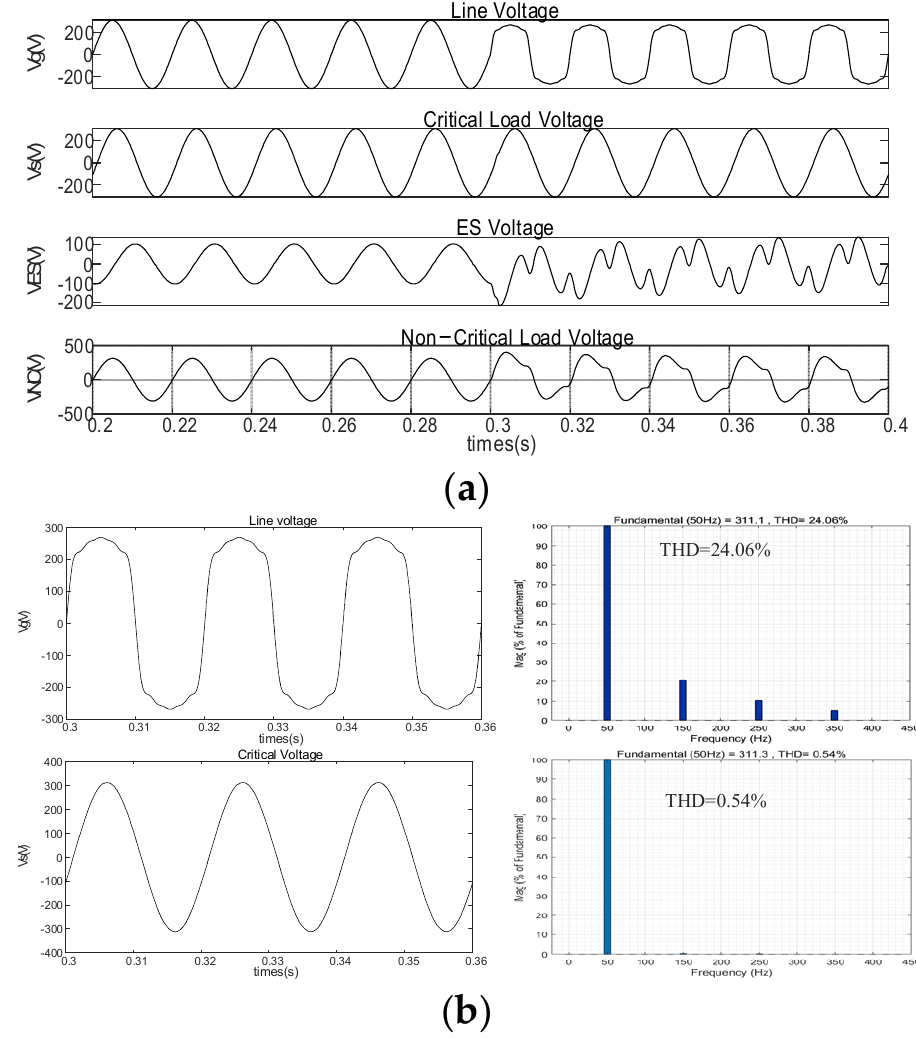
Figure 6. Simulation waveforms based on the proposed control method under the mode of pure reactive power compensation with grid distortion. ( a ) Comparison of the waveforms between ideal grid condition and distorted condition. ( b ) THD analysis of line voltage and critical load voltage under distorted grid condition.